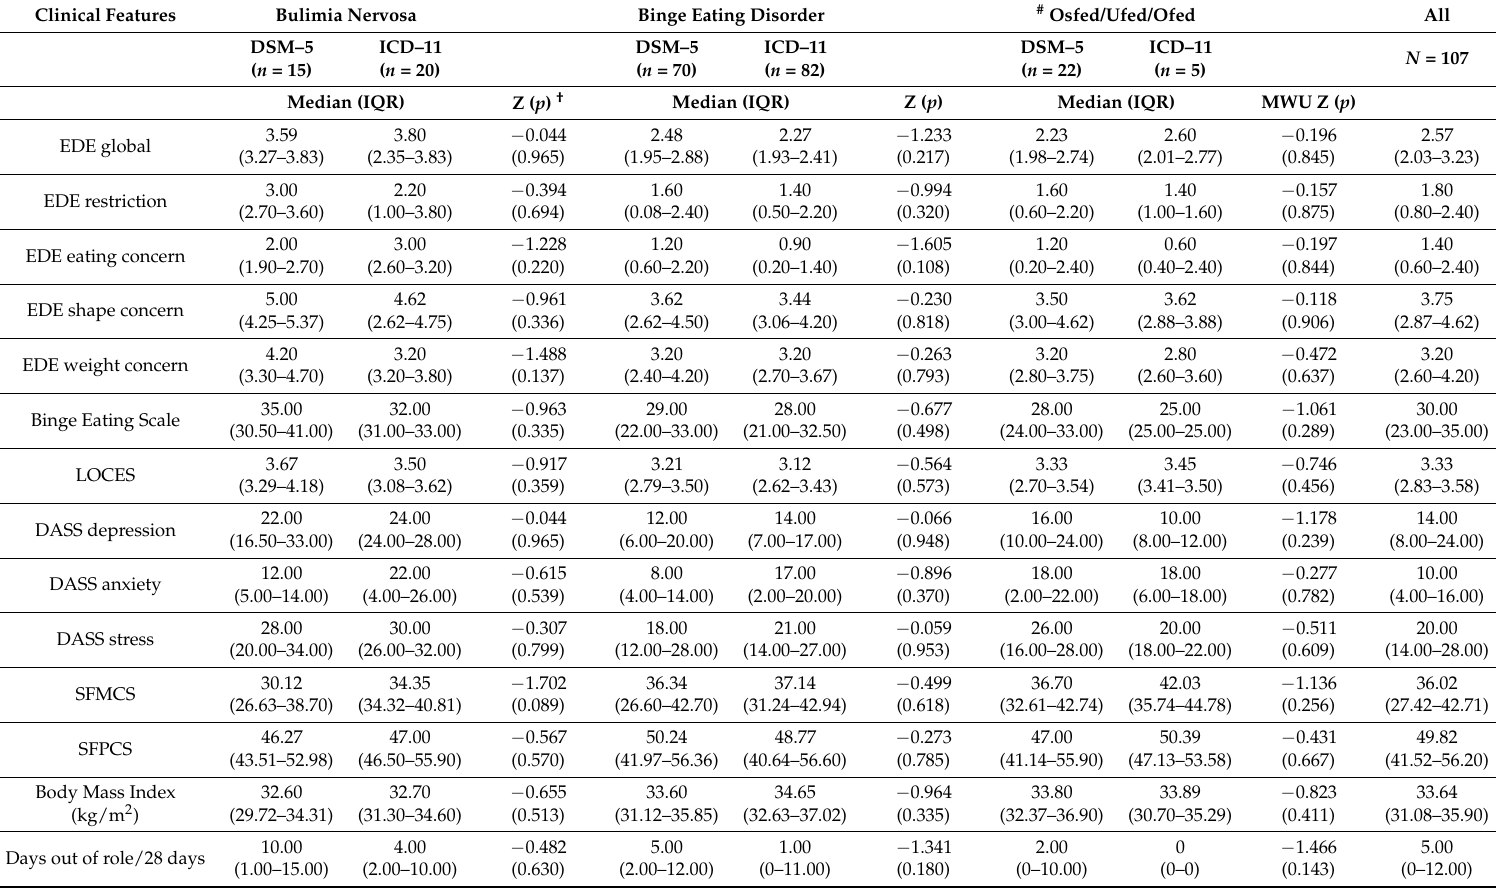
Table 1. Comparative clinical features of the study participants ( N =